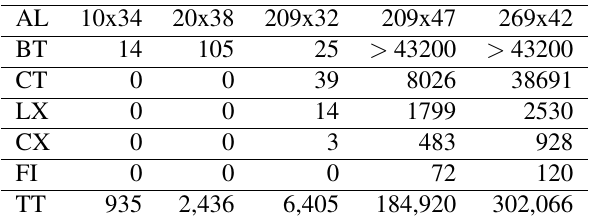
Table 5. Execution time in seconds of the algorithm CT EXT and their fast implementation, handling several real